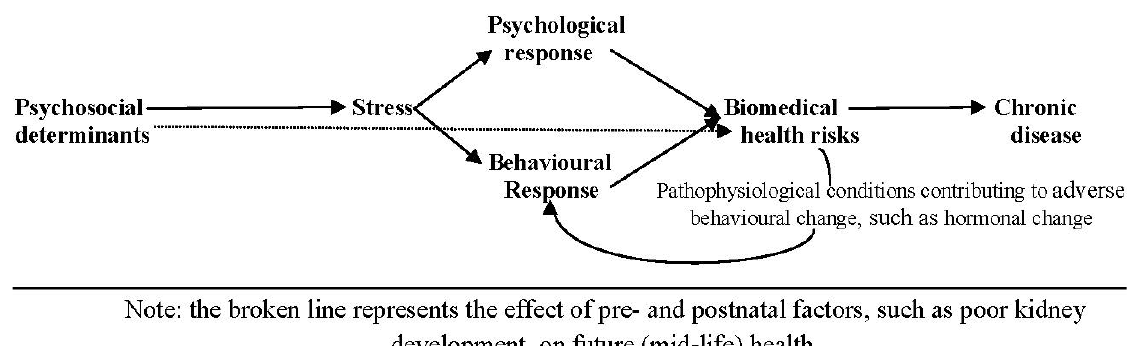
Figure 1. The pathway from the psychosocial determinants of health to chronic